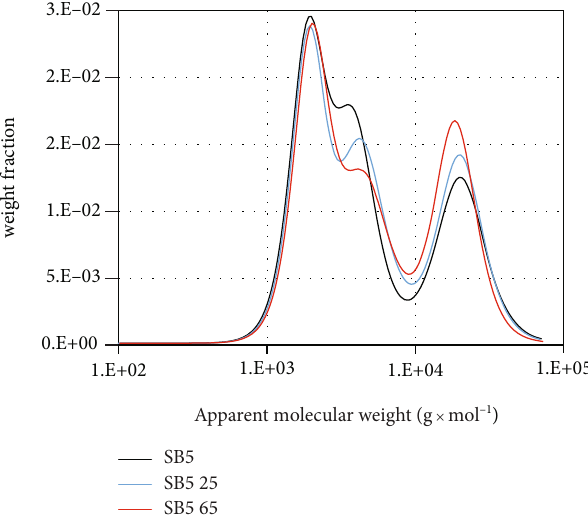
Figure 8: AMWD of SB5 at di ff erent levels of